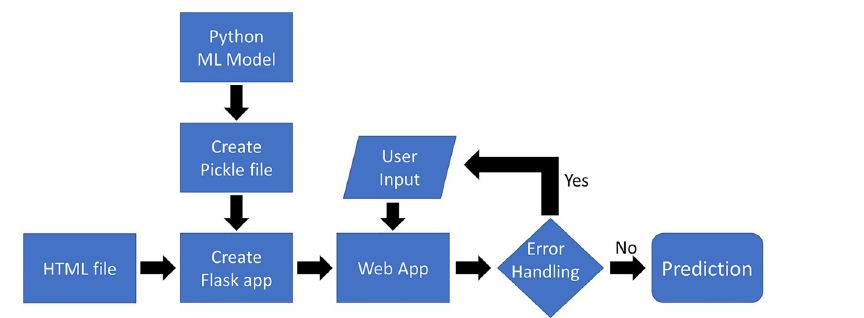
Fig 3. Flowchart of the curve progression model deployment.